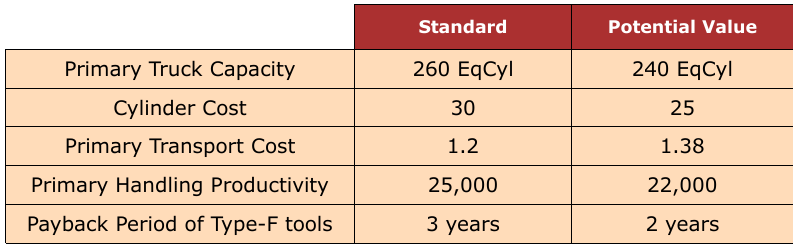
Table 4. Parameter